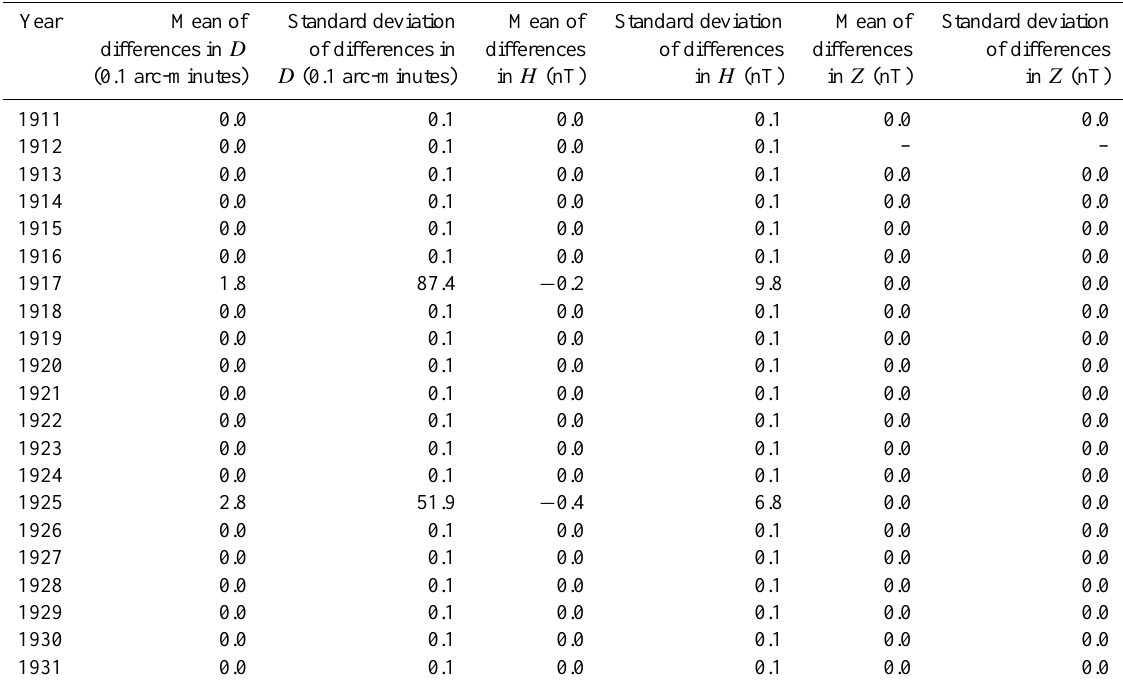
Fig. 5. Ratios of monthly means of Eskdalemuir and Niemegk IHV indices based on data available at the Edinburgh WDC after 9 August 2010. Table 1. Annual statistics of differences between post-processed Kyoto WDC hourly values (option 1 in text) and Edinburgh WDC hourly values prior to 9 August